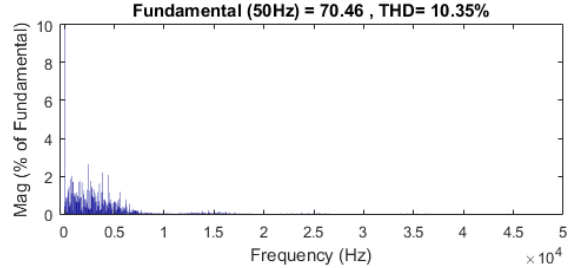
Figure 13. The curve of phase current for the proposed MPDTC.